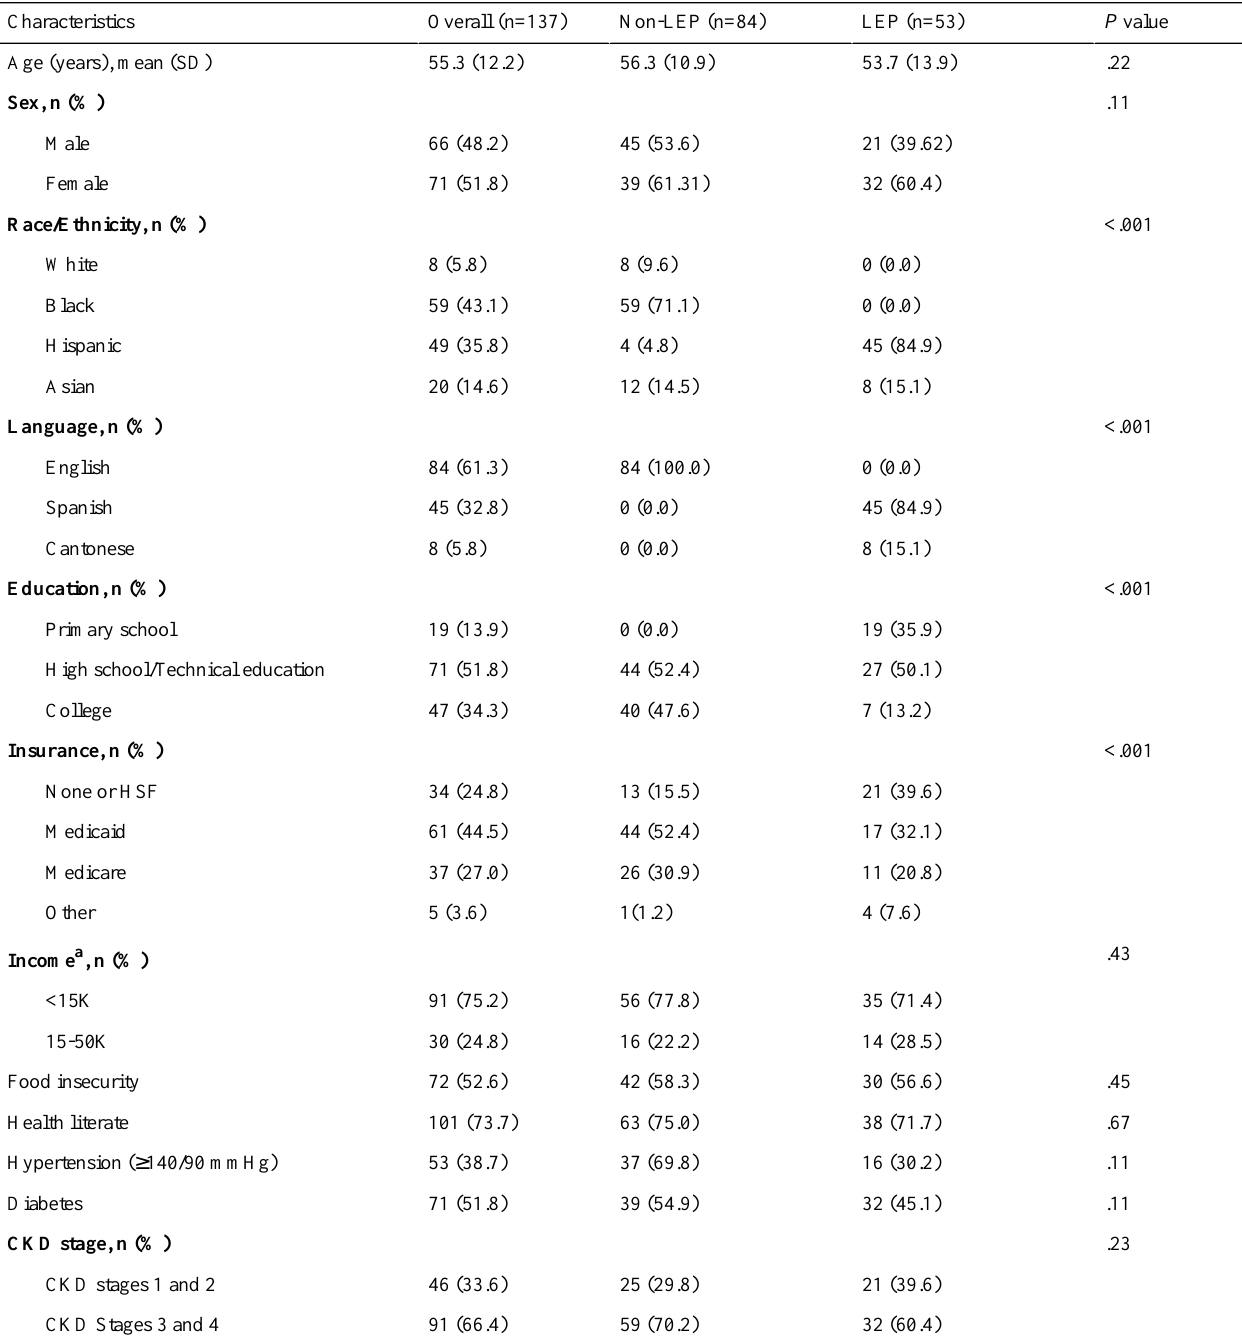
Table 1. Sociodemographic characteristics of the study